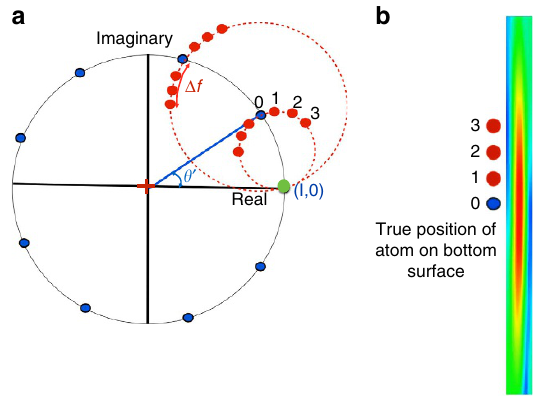
Figure 1 | Schematic representation of the exit wave function in Argand space and propagation intensity. ( a ) The complex values of pixels in the centre of each atomic column are represented as blue dots. The red dots correspond to pixels of the wave function if propagated across a distance D f away from the exit surface of the sample. Black circle is called ‘mass circle’ and the red dashed circle is called ‘defocus circle’. ( b ) The propagation intensity of one atomic column. The true position of atom at the bottom exit surface is at the position of maximum intensity (blue point).